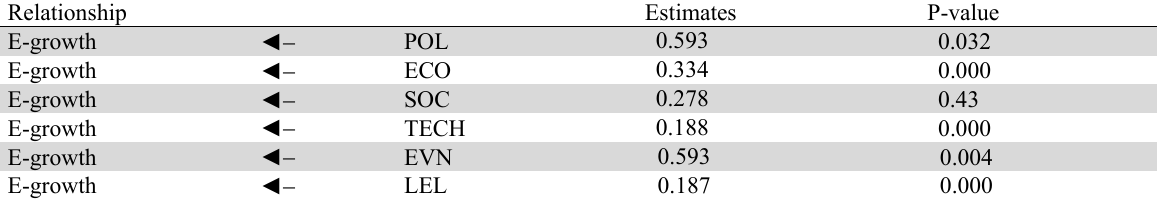
Results of causality between concepts in research model Relationship Estimates P-value E-growth ◄  POL 0.593 0.032 E-growth ◄  ECO 0.334 0.000 E-growth ◄  SOC 0.278 ◄  ◄